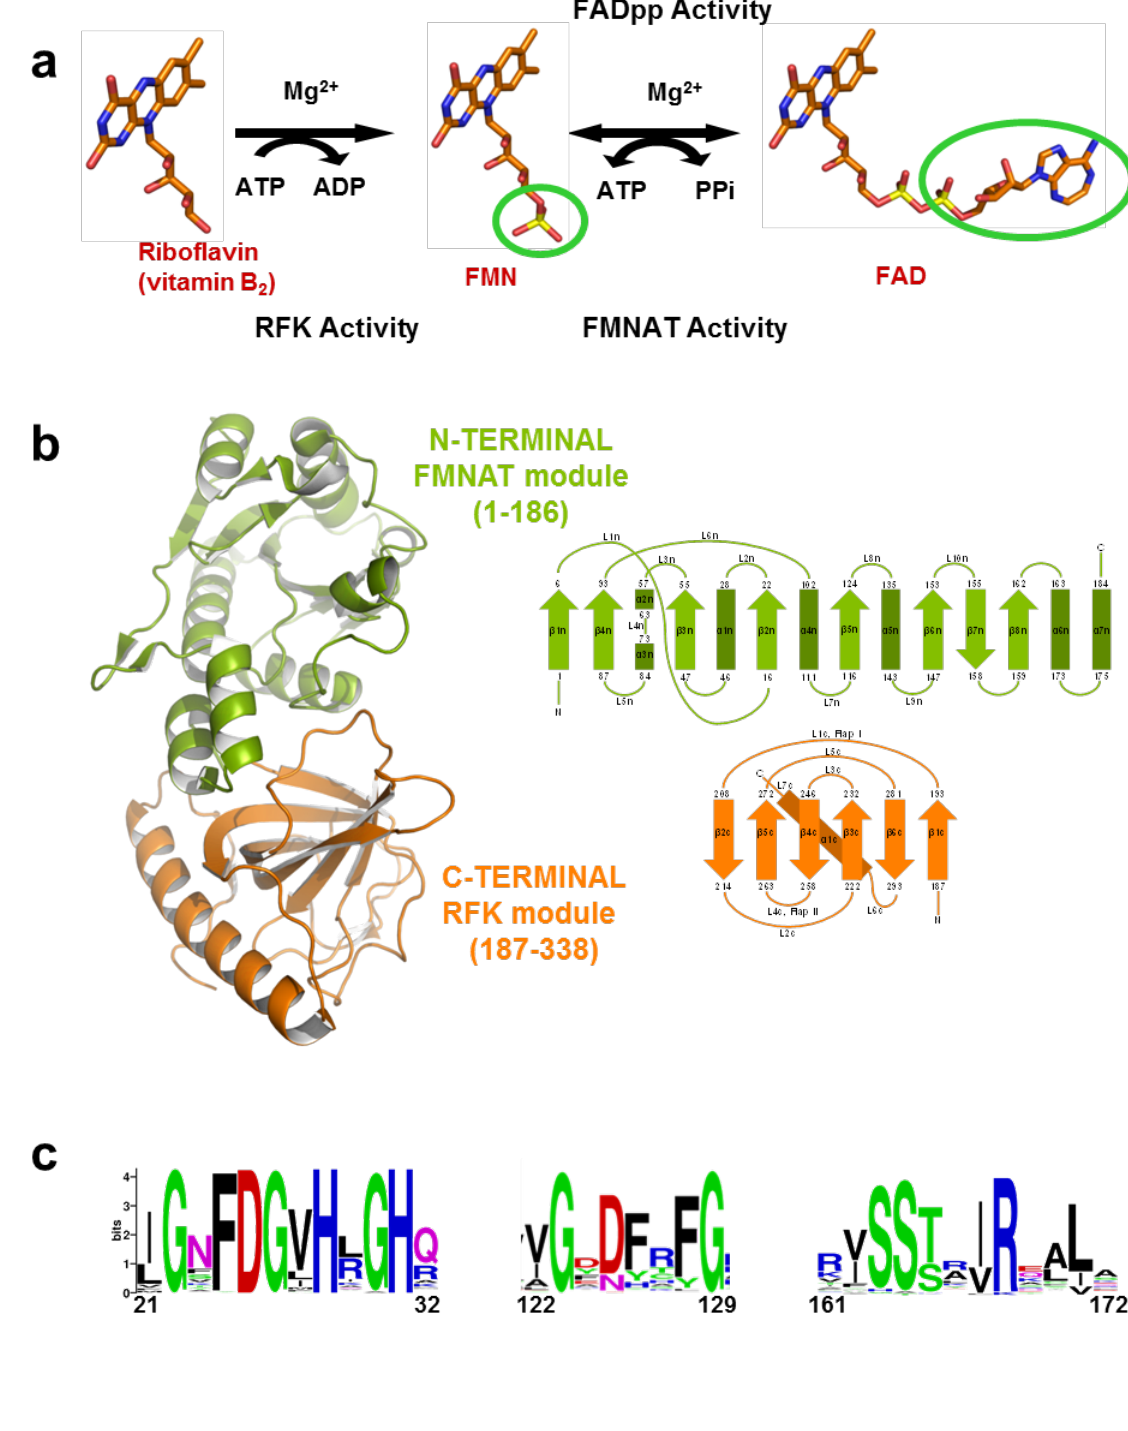
Figure S1. ( a ) Scheme for the reactions catalysed by the RFK and the FMNAT modules of Ca FADS. ( b ) Cartoon representation and topology of the crystal structure of Ca FADS (2X0K). The N -terminal FMNAT and C -terminal RFK modules are coloured in green and orange, respectively. ( c ) Logo of sequence homology of the motifs putatively involved in the FMNAT catalytic activity in the FADS family. The sequence logo was produced using the server (available online: http://weblogo.berkeley.edu; accessed on15 February